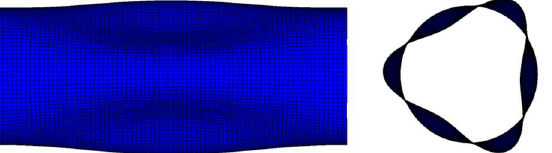
Figure 2. Example of the buckling mode of the cylindrical shell ( n = 3).